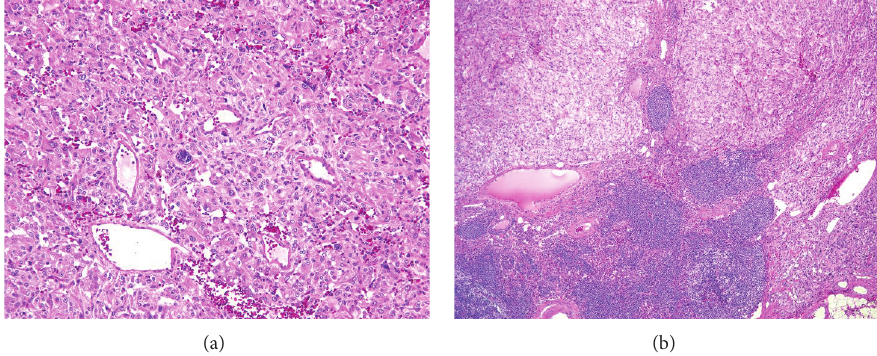
Figure 3: (a) Microscopically, polygonal basophilic atypical cell proliferated in rich vascular network. There were mitotic cells and multinuclear cells (HE, original magnification × 100). (b) Tumor cell involved lymph node (HE, original magnification ×